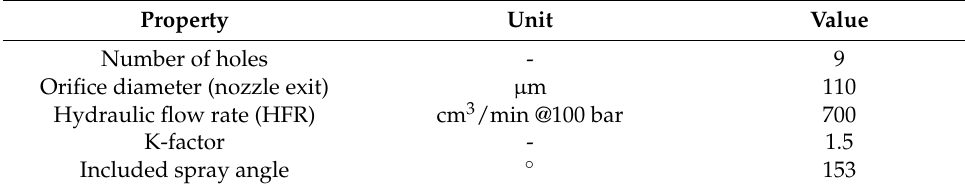
Table 1. Injector specifications.